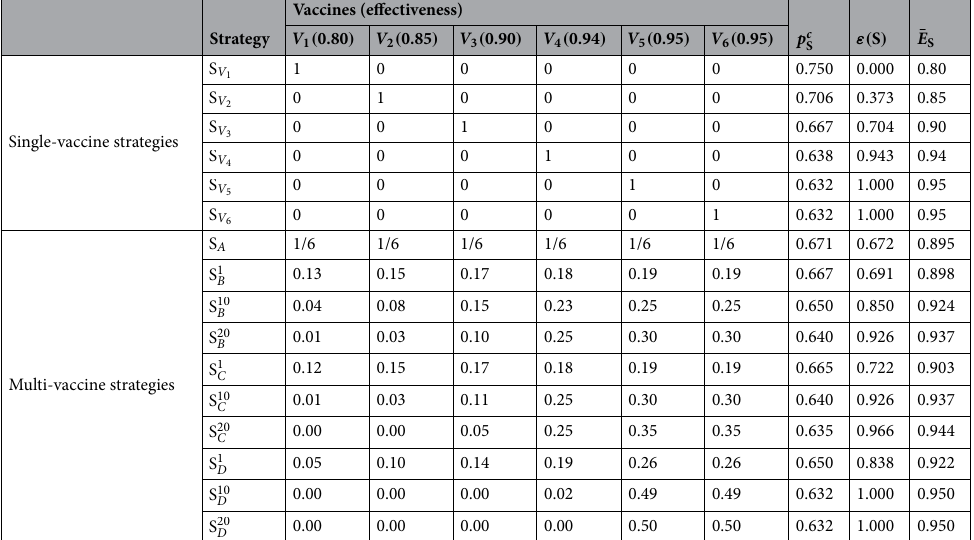
Table 1. Illustration of some strategies with their specific weights, herd-immunity threshold, relative effectiveness and mean effectiveness of